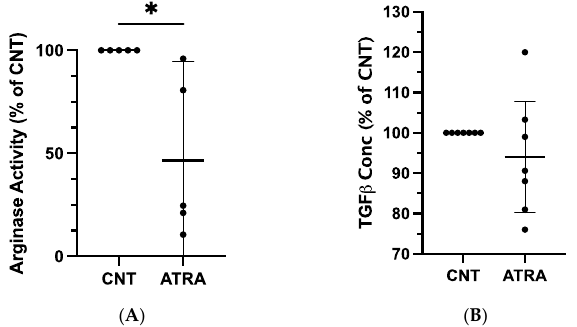
Figure 2. Evaluation of protein expression in ATRA-treated canine MDMs, as compared to control MDMs. Canine PBMCs were differentiated into MDMs in the presence of rhM-CSF (25 ng/mL), and ATRA (2 µM) or vehicle control media for 5 days. An equal number of ATRA-treated and control MDMs from each dog were input into each assay. ( A ) Arginase activity of control and ATRA-treated MDM lysates. n = 5. ( B ) TGF- β 1 concentration in supernatant of control and ATRA-exposed MDMs after 24 hrs incubation. n = 7. Results are displayed as a percentage of paired control MDM values. The mean and 95% CI are shown, and individual data points are plotted. * p < 0.05.